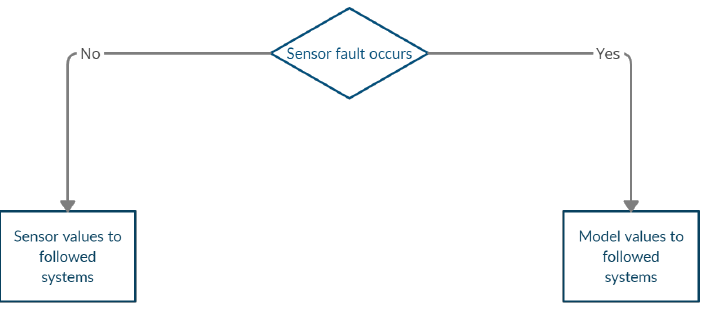
Figure 9. Process of the sensor